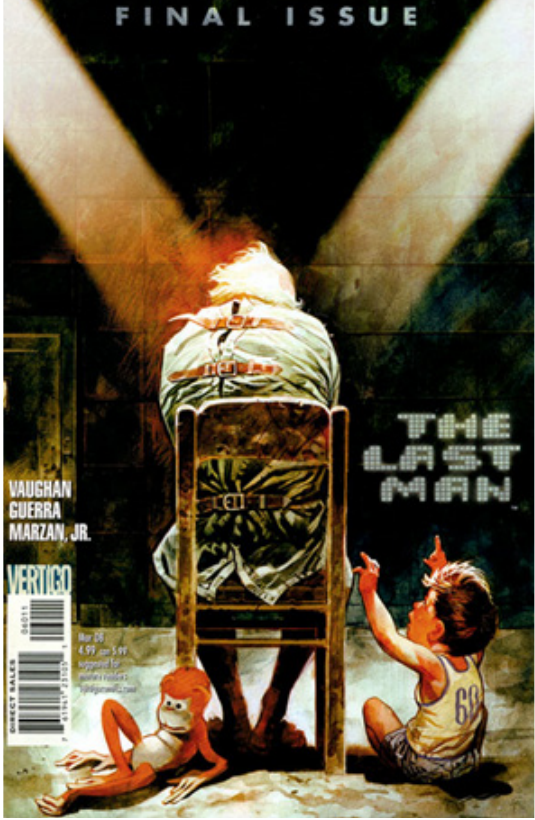
Figure 7. Y: The Last Man: Whys and Wherefores Vol. 10 (2008), cover by Massimo